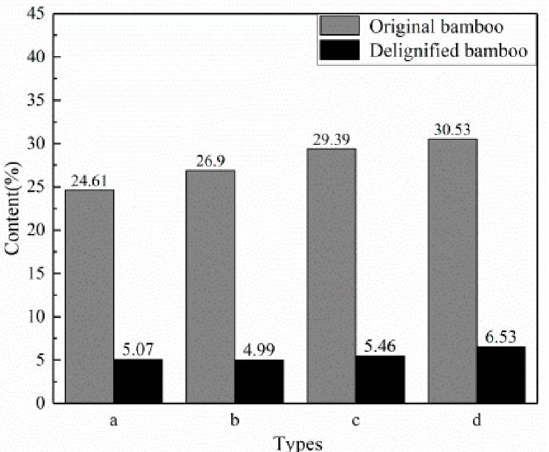
Figure 9. Lignin content of the delignified bamboo samples (( a ) IB; ( b ) HIB; ( c ) OB; ( d ) HOB). Reprinted from [34] under CC-BY license.